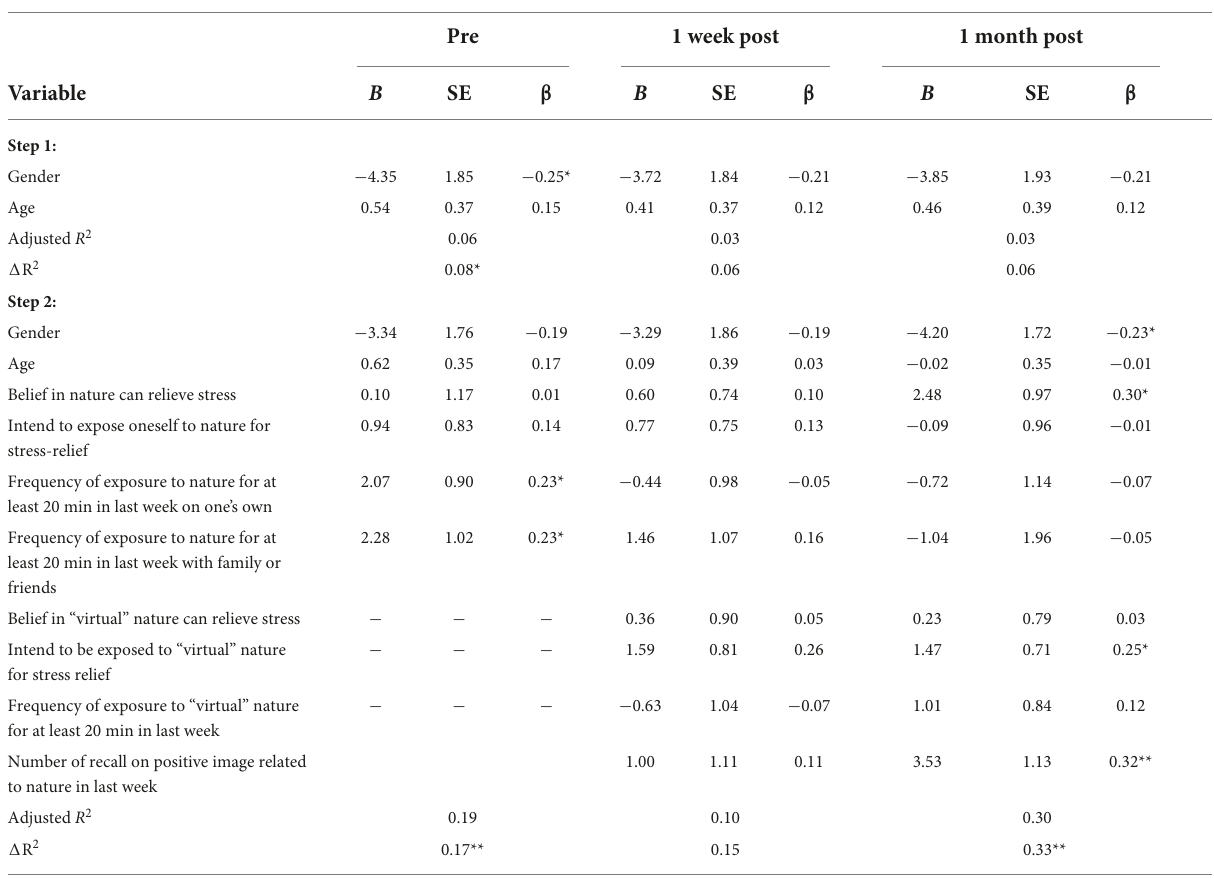
TABLE 6 Summary of Hierarchical Multiple Regression result on connectedness to nature ( N = 90). DV = Connectedness to